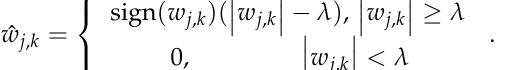
Figure 4. Best tree decomposition principle.